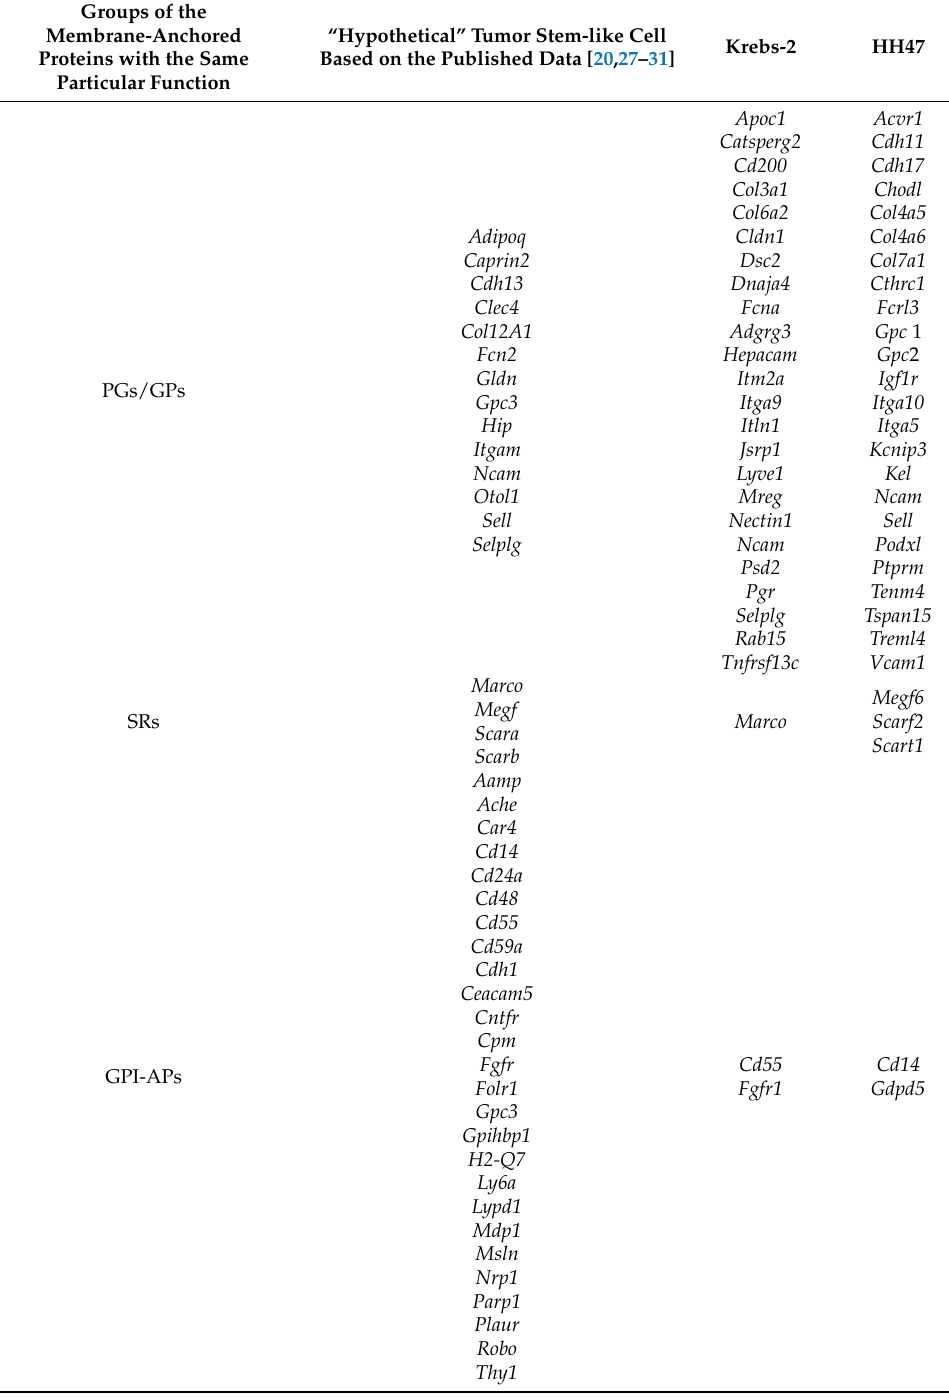
interaction between cells and dsDNA, which, in turn, presumes the active transcription of the respective genes. Table 2. General comparative table of the group-specific factors of the integral cell surface molecular profile of a “hypothetical” TSC, i.e., carrying all possible members of the three functional groups (PGs/GPs, GPI-APs, and SRs) and those of real Krebs-2 and HH47 TSCs. Groups of the Membrane-Anchored “Hypothetical” Tumor Stem-like Cell Proteins with the Same Based on the Published Data [20,27–31] Particular Function